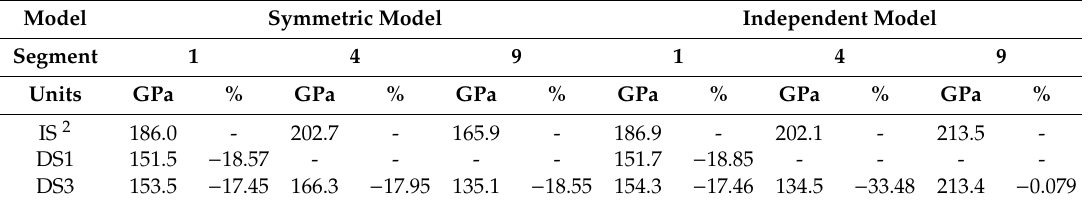
Table 6. GA results: elastic modulus (E DSx ) and damage severities 1 of damaged segments (GPa, %). Model